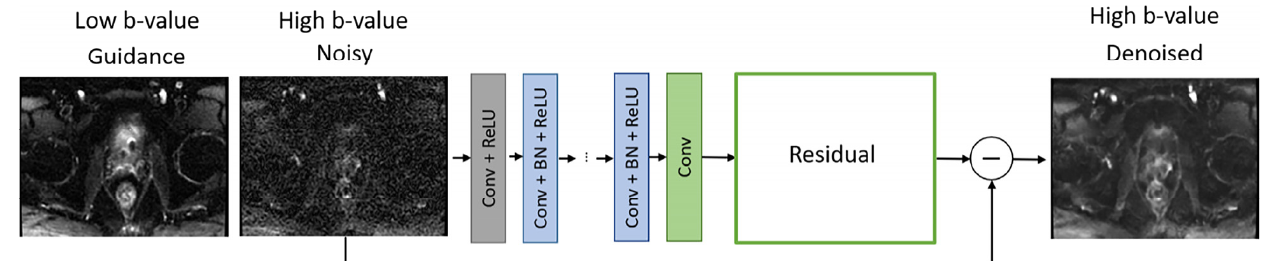
Figure 2. Denoising convolutional neural network (DCNN) architecture. The DCNN denoises the high b -value image using the low b -value image as a guide. The DCNN is based on residual learning and uses a loss function that combines an L2-term and an L1-term for an appropriate tradeoff between denoising and smoothing.